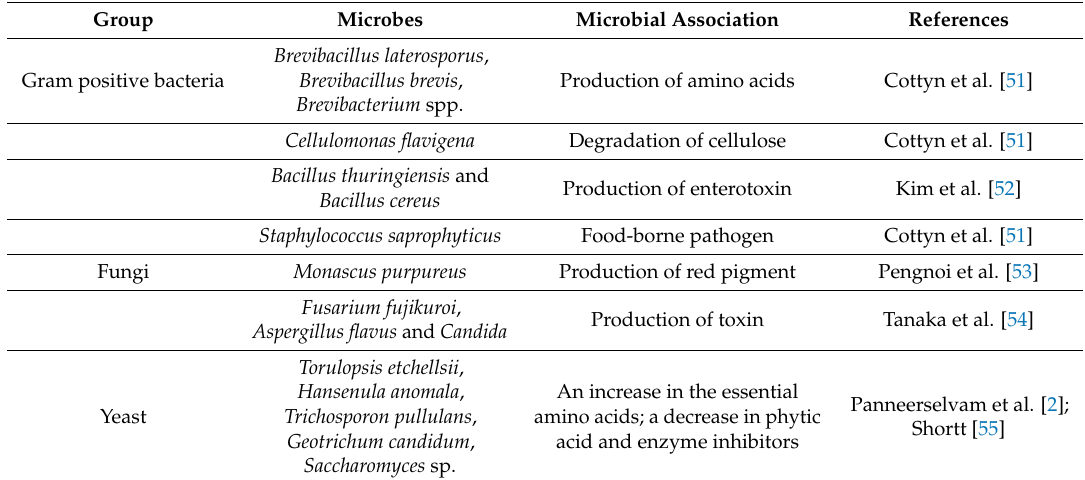
Table 3. Summary of major microbial association in